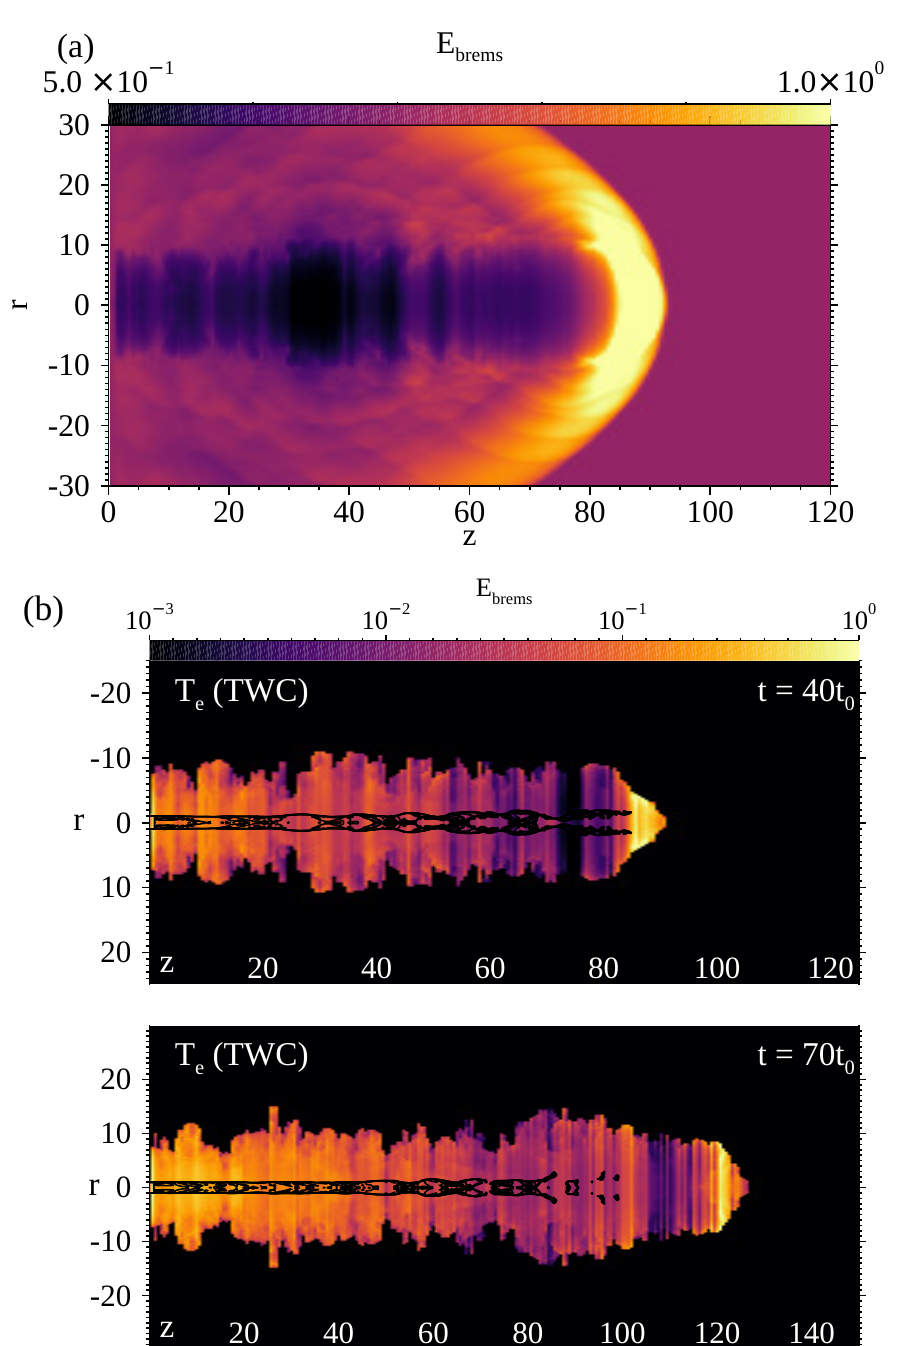
Figure 6. ( a ) the radiation intensity map at t = 40 t 0 for model TWC; ( b ) the radiation intensity maps Figure 6. ( a ) The radiation intensity map at t = 40 t 0 for model TWC. ( b ) The radiation intensity maps of the jet and cocoon computed by setting e brems = 0 when T e < T e,amb at t = 40 t 0 ( top ) and t = 70 t 0 of the jet and cocoon computed by setting (cid:101) brems = 0 when T e < T e,amb at t = 40 t 0 ( top ) and t = 70 t 0 ( bottom ). The black contours show the contour of z-velocities of 0.38c ,0.34c, and 0.32c. ( bottom ). The black contours show the contour of z -velocities of 0.38 c, 0.34 c, and 0.32